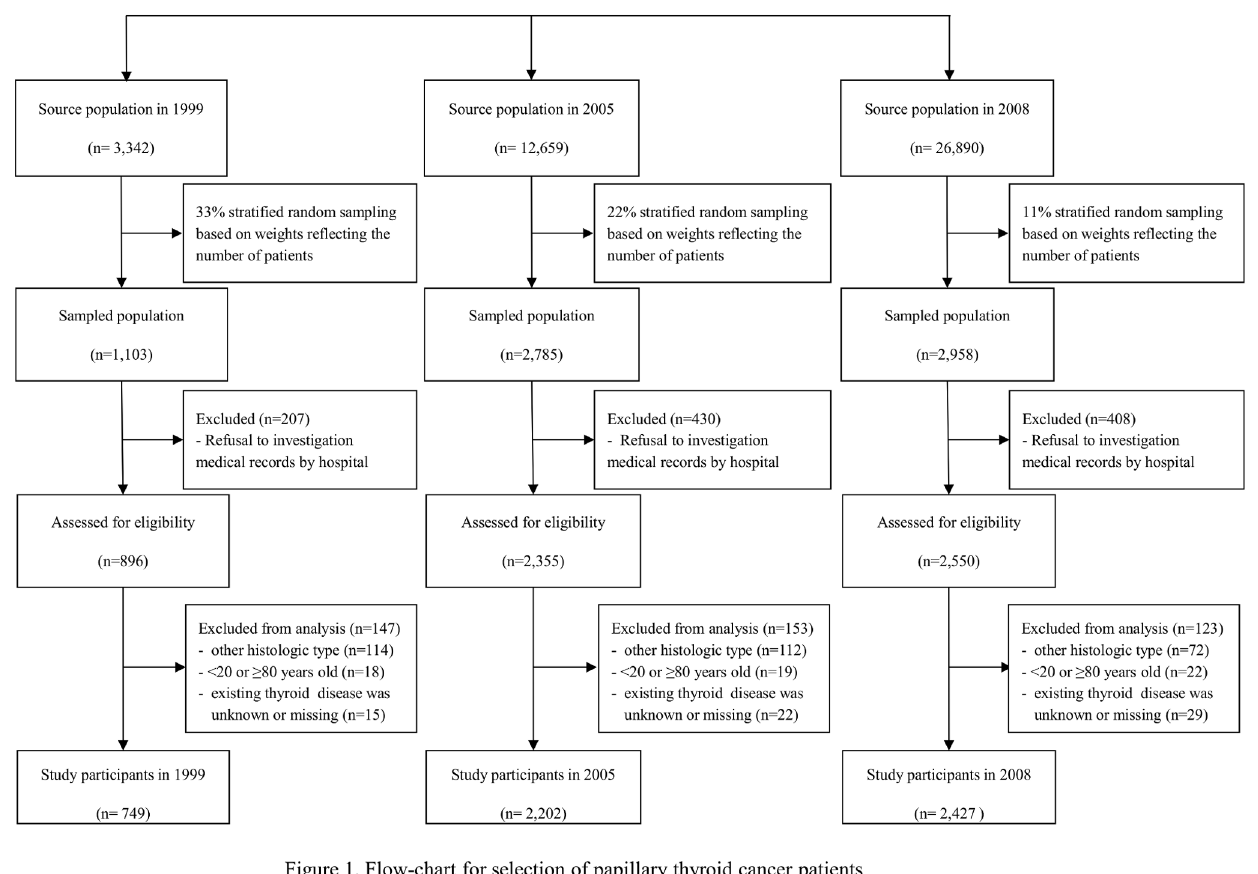
Figure 1. Flow chart for the selection of papillary thyroid cancer patients.